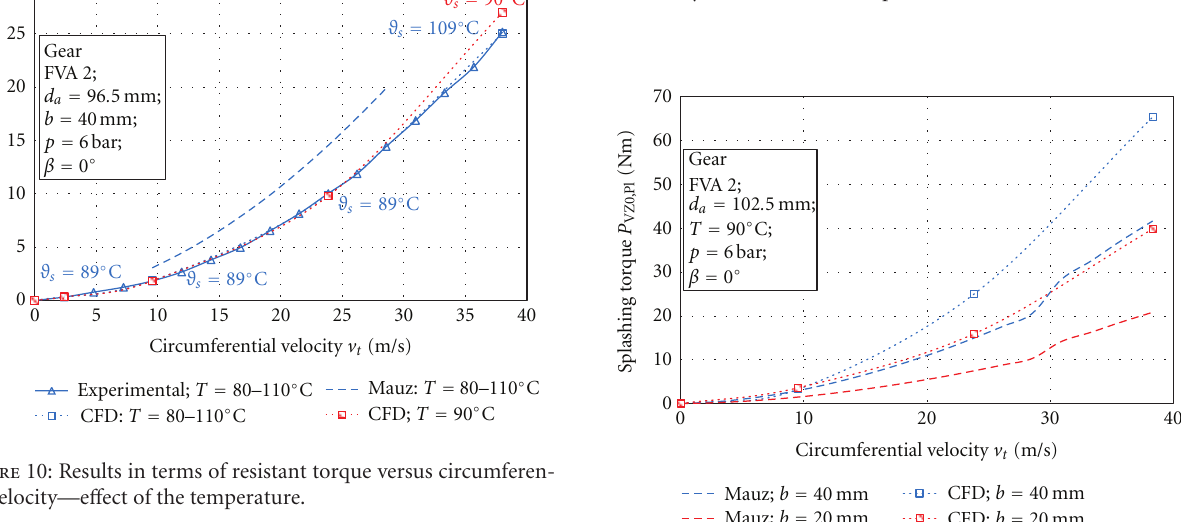
Figure 11: Results in terms of resistant torque versus circumferen- tial velocity—influence of the tip diameter.